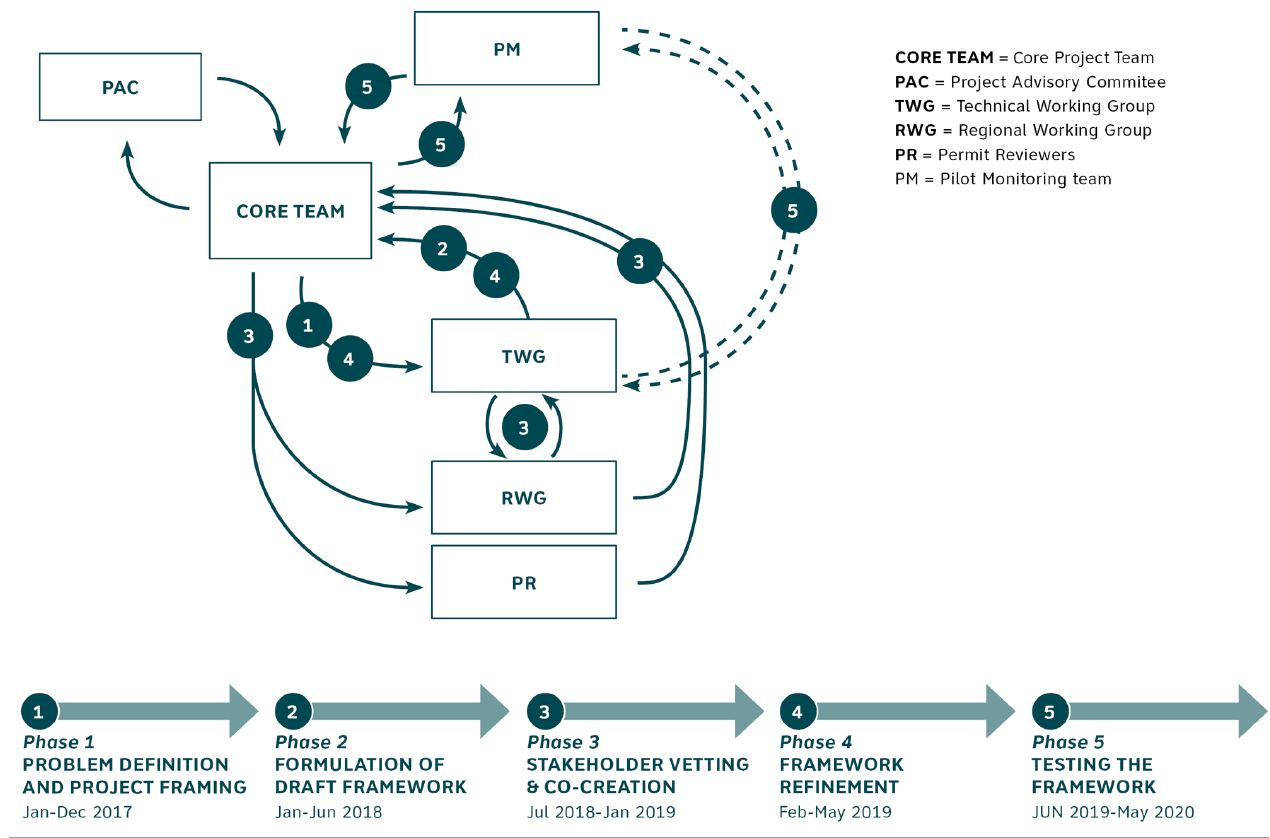
Fig. 3 . Key aspects of framework development. Each phase builds off the outcomes of the prior